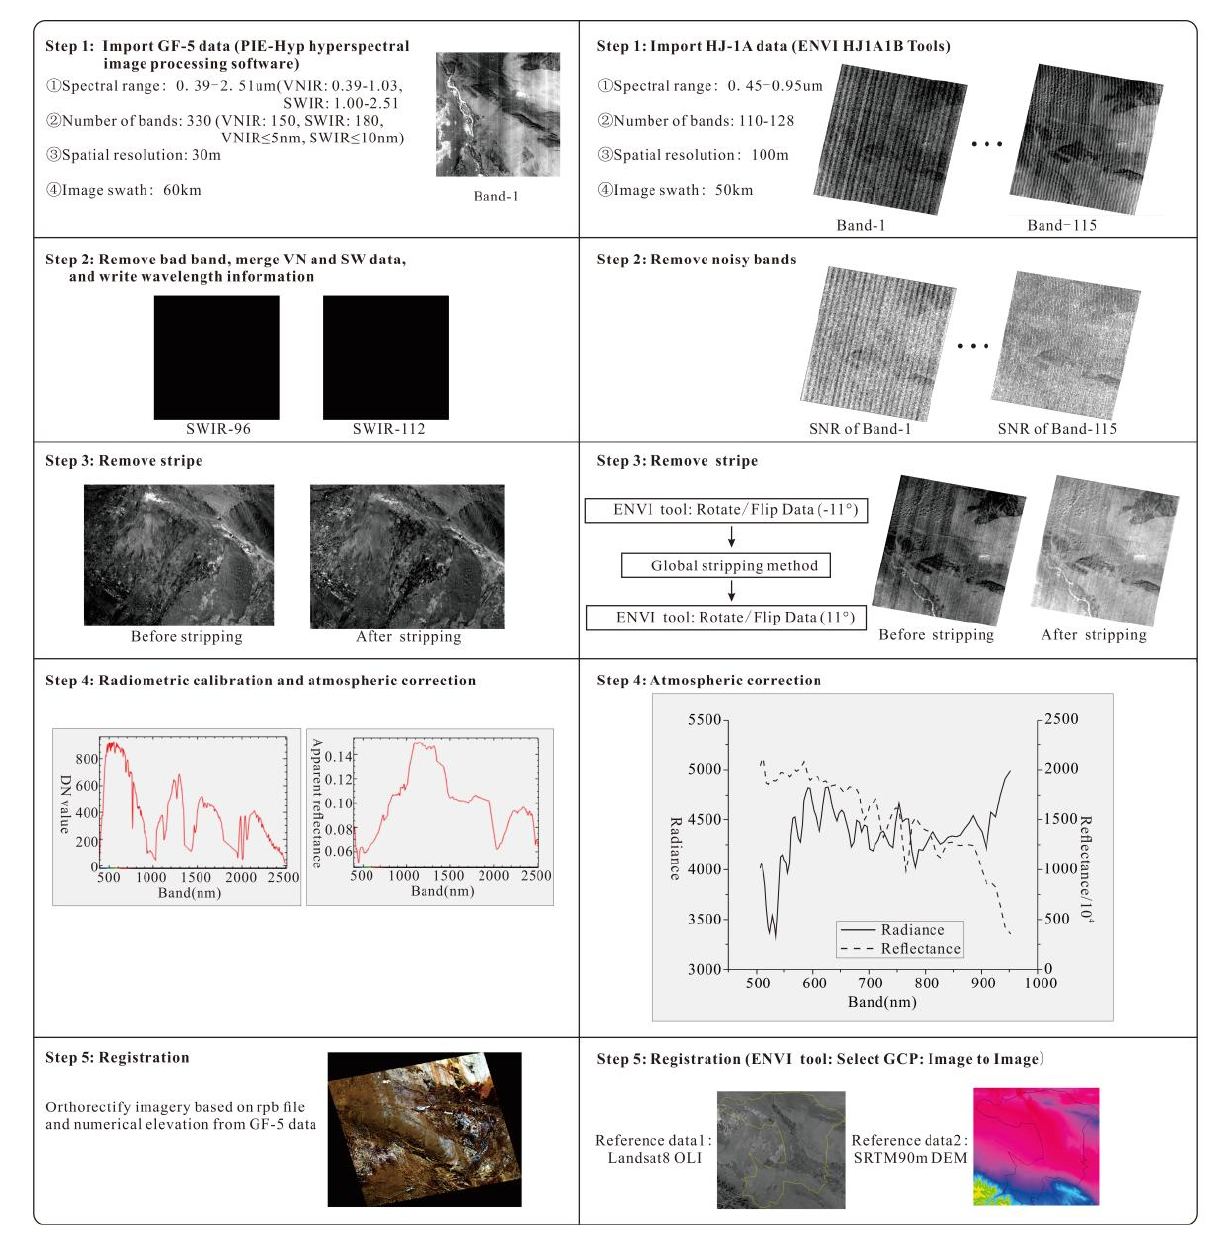
Figure 3. GF-5 and HJ-1A data preprocessing flow chart.